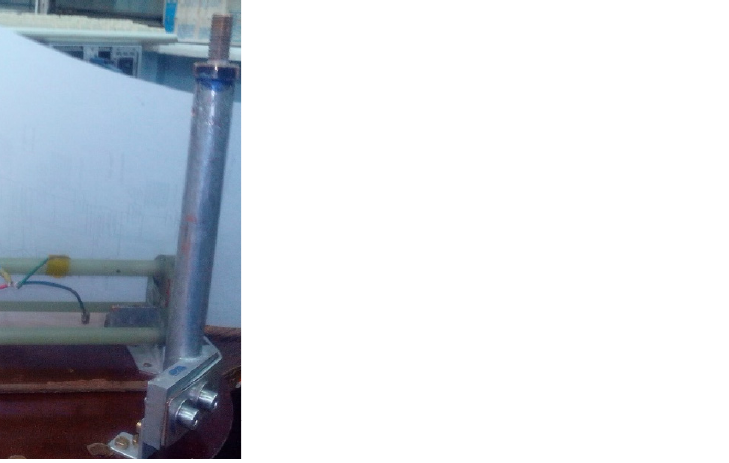
Figure 5. Sample holder with the S-Innovations 12 mm 2G HTS tape 120 mm in length without copper coating prepared for the low voltage check-up experiments. Prior to the high voltage experiments, the potential taps were removed, and the current leads were additionally insulated.